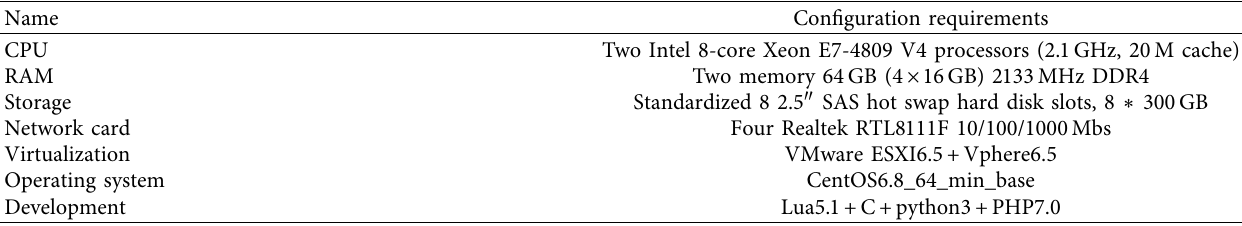
Table 1: VMware virtualization of cloud hardware and software parameters.